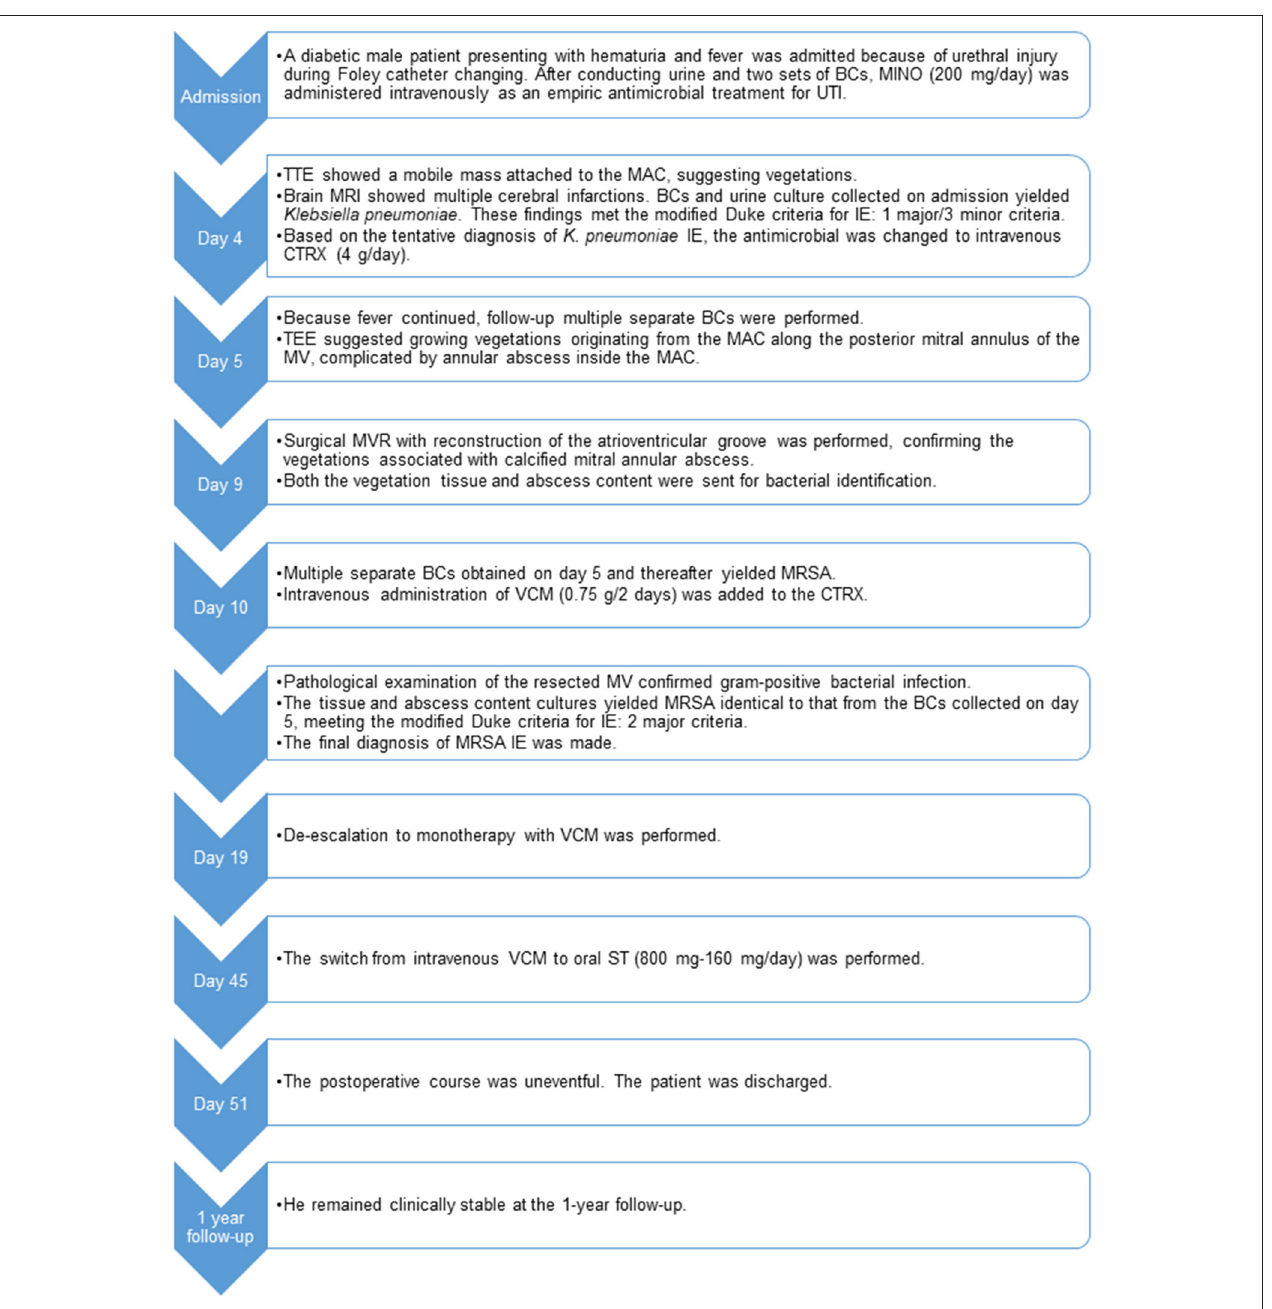
FIGURE 4 | Timeline of case presentation. BCs, blood cultures; CTRX, ceftriaxone; IE, infective endocarditis; MAC, mitral annular calcification; MINO, minocycline; MRI, magnetic resonance imaging; MRSA, methicillin-resistant Staphylococcus aureus ; MV, mitral valve; MVR, mitral valve replacement; ST, sulfamethoxazole/trimethoprim; TEE, transesophageal echocardiography; TTE, transthoracic echocardiography; UTI, urinary tract infection; VCM, vancomycin.